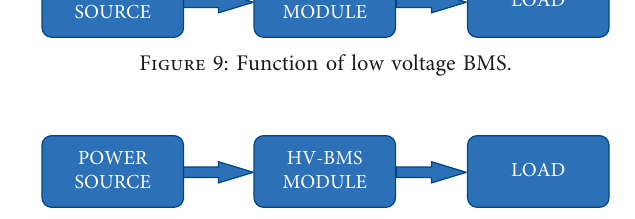
Figure 10: Function of high voltage